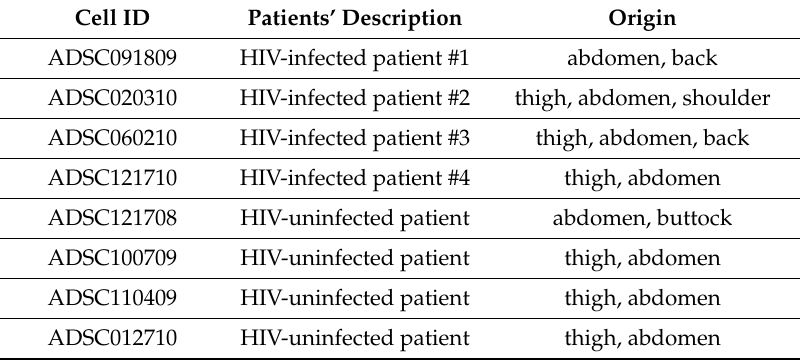
Table 1. Origin of adipose tissue-derived